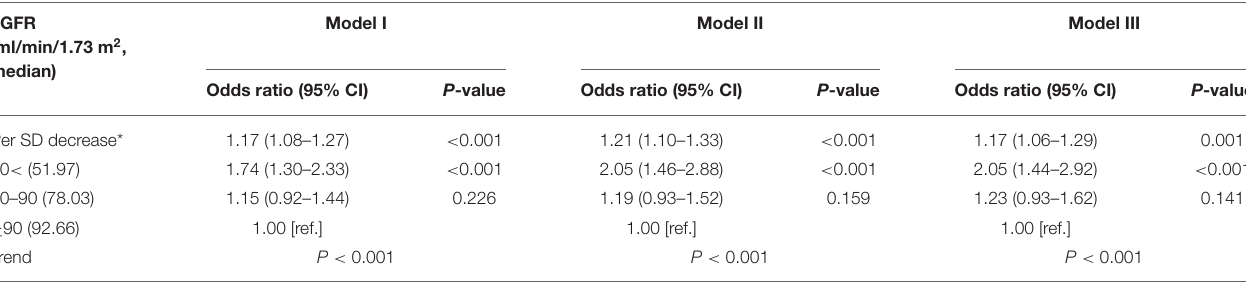
TABLE 4 | Odds ratios (95% CI) for eGFR, calculated by CKD-EPI equation, in relation with low HDL-C. eGFR (ml/min/1.73 m 2